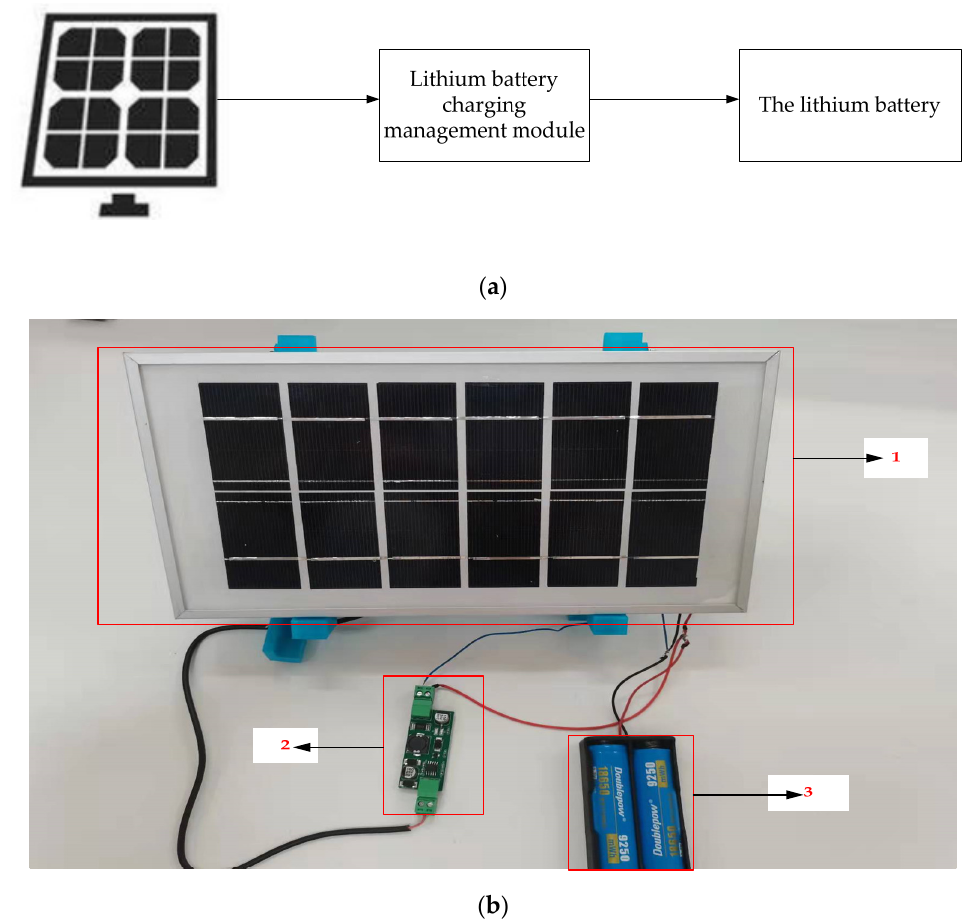
Figure 2. Structure block diagram and physical drawing of the power management system. ( a ) Block diagram of power management system structure; ( b ) Physical map of the power management sys- tem.